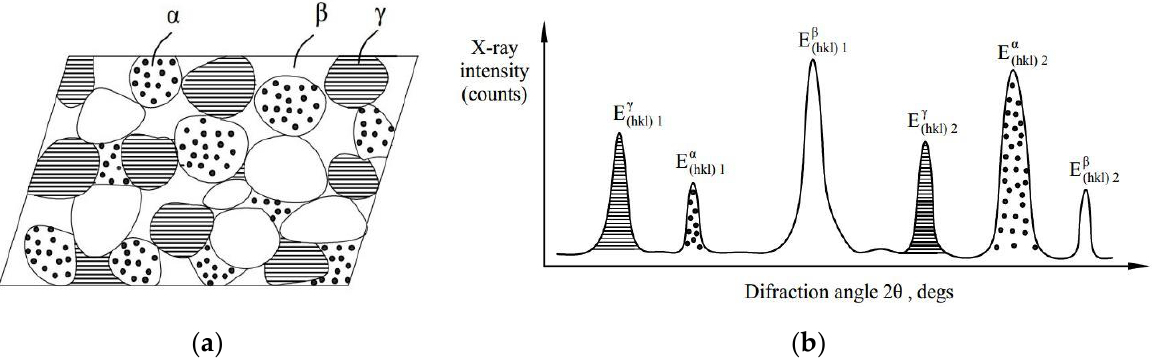
Figure 9. Microstructure of three-phase material ( a ) and ( b ) their peaks in a diffraction line. Five samples of commercial triple-phase ceramic T15K6, containing three phases